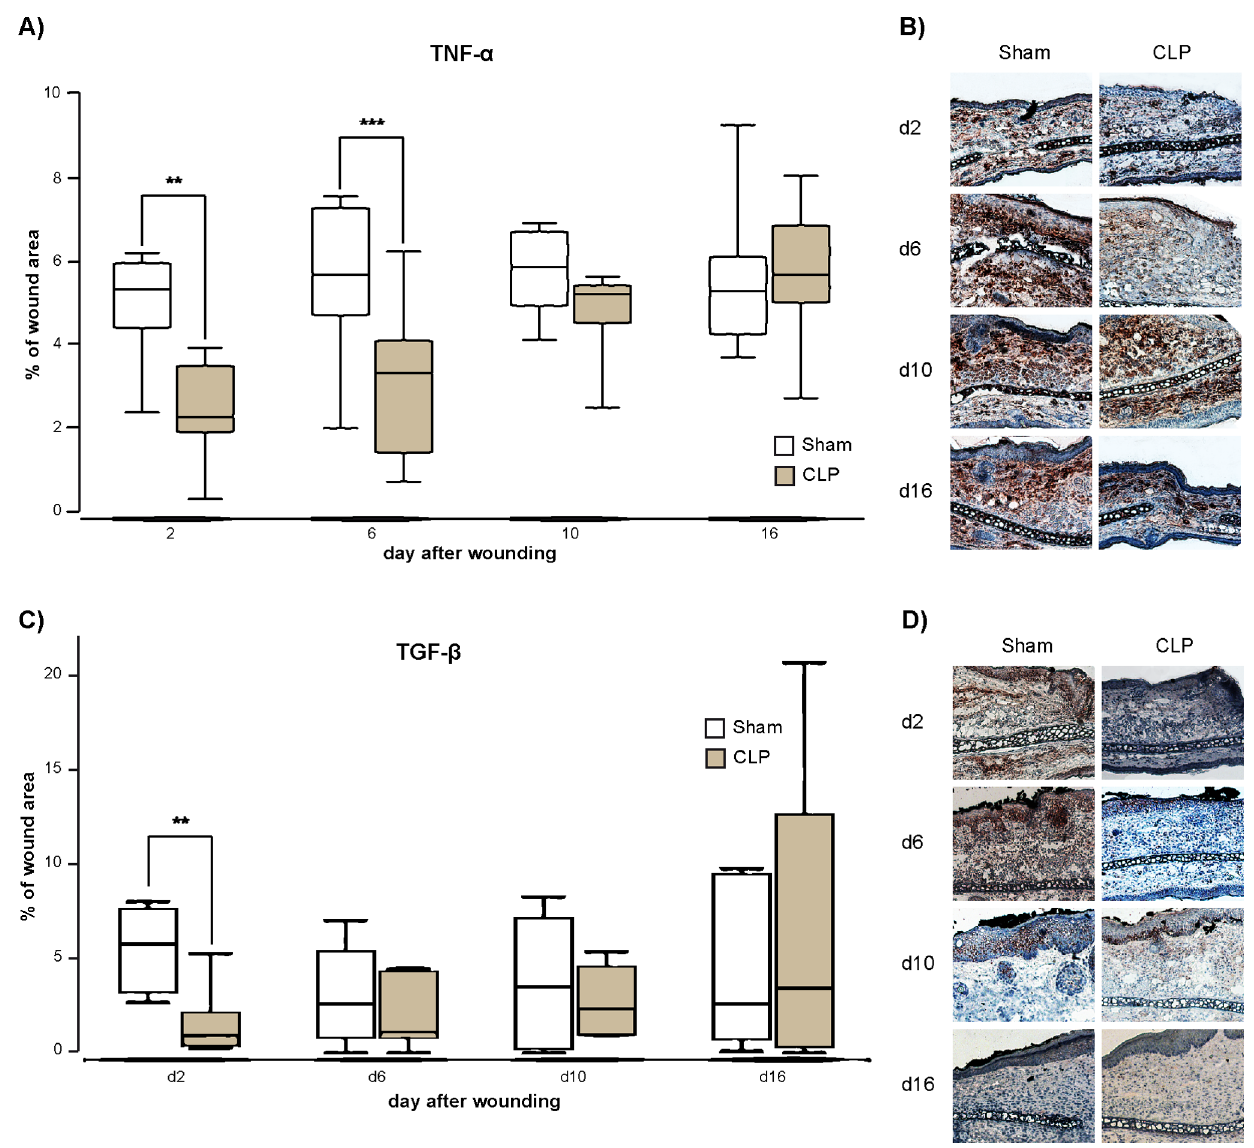
Figure 3. Expression of TNF- a and TGF- b in wounds. A. Percentage of TNF a -positive area on days 2, 6, 10 and 16 after wounding. Septic animals express significant less TNF- a compared to control animals on day 2 and 6 after wounding. (Data are expressed as box plots of the median, n =8). B. Representative pictures of TNF- a staining at the wound margin captured under 100x magnification of sham and CLP animals on day 2, 6, 10 and 16 after staining for TNF- a . Wound margin is located on the right side. C. Percentage of TGF- b -positive area in epidermis on days 2, 6, 10 and 16. Mice that underwent CLP procedure show a reduced level of TGF- b on day 2. (Data are expressed as box plots of the median, n =7). D. Representative pictures of TGF- b staining at the wound margin captured under 100x magnification of sham and CLP animals on day 2, 6, 10 and 16 after staining for TGF- b . Wound margin is located on the right side. ** p , 0,01; *** p , 0,05.